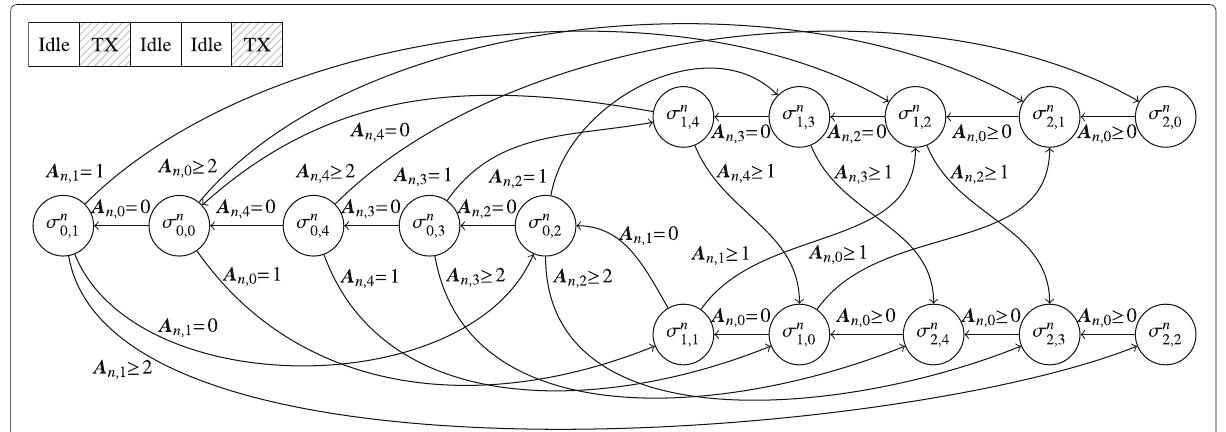
Fig. 5 Schedule for l S = 5, T n = ( 1,4 ) and corresponding state diagram for K = 2